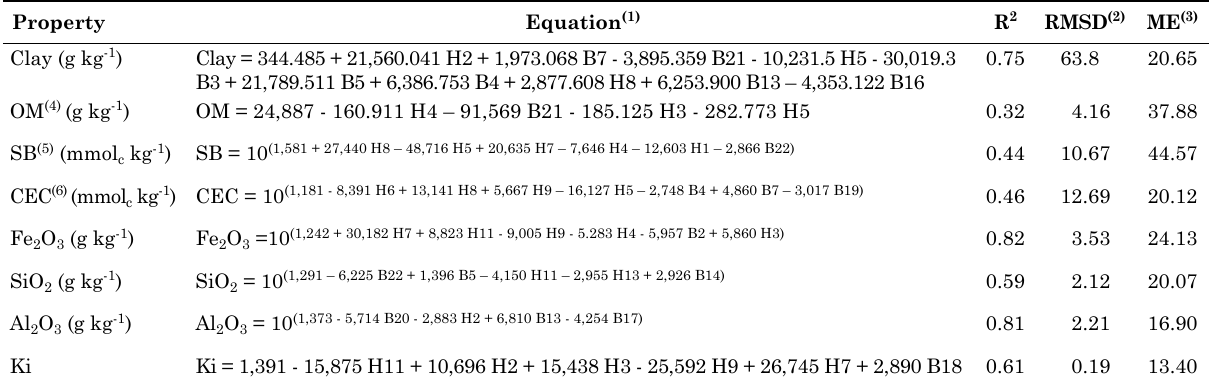
Table 1. Multiple regression equations developed from soil reflectance and obtained at ground level Property